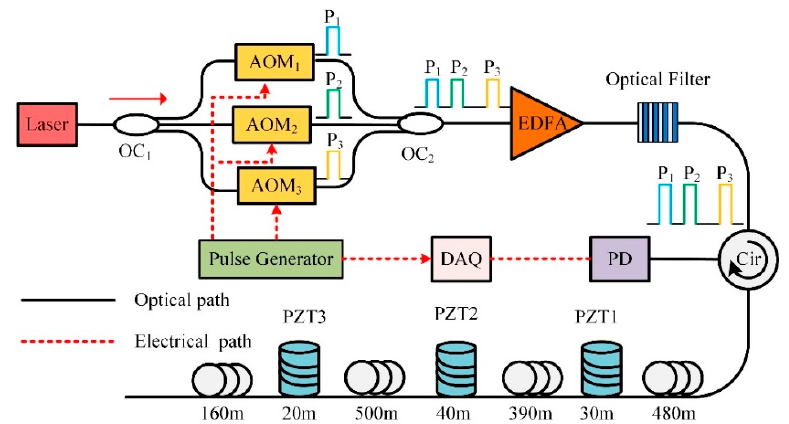
Figure 2. The scheme of the proposed phase-sensitive optical time domain reflectometry ( Φ -OTDR) sensing system.